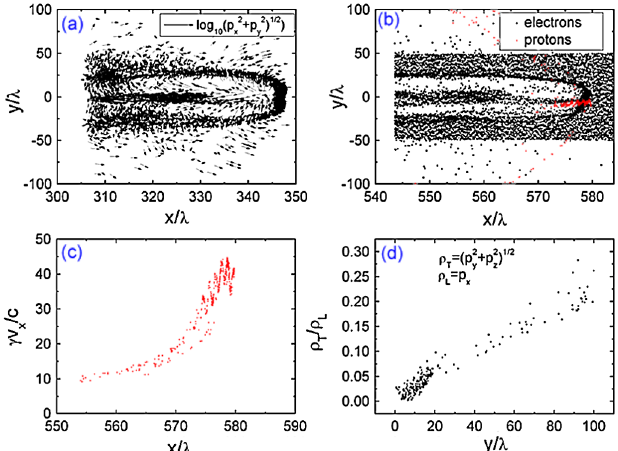
FIG. 1. (Color) (a) Distribution of the momentum vector of the background electrons at t ¼ 360 T . (b) The background electron and microtarget proton density distributions at t ¼ 600 T . (c) The proton momentum spectrum at t ¼ 600 T . (d) The transverse distribution of (cid:5) L =(cid:5) T at t ¼ 800 T , where y is the distance from the bubble center, and (cid:5) L ¼ (cid:6) p m p v px and (cid:5) T ¼ 1 = 2 are the longitudinal and transverse momen- (cid:6) m v 2 v 2 p p ð py þ pz Þ tum of the trapped protons.